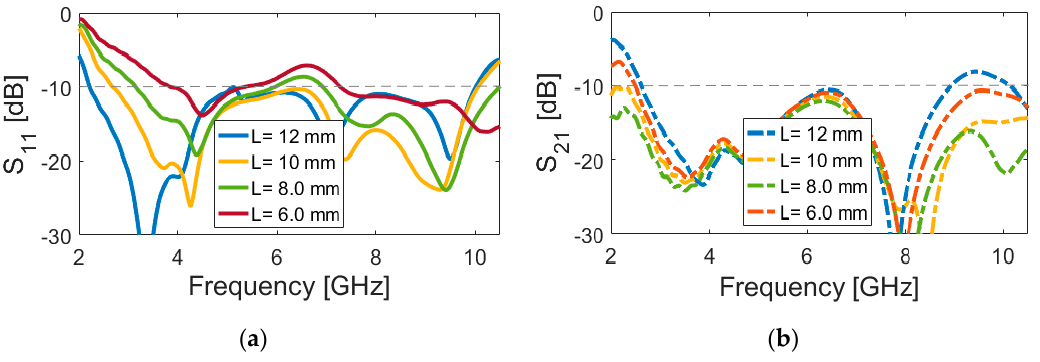
Sensors 2020 , 19 FOR PEER REVIEW Figure 6. ( a ) S 11 and ( b ) S 21 characteristics for di ff erent values of ( a ) L.